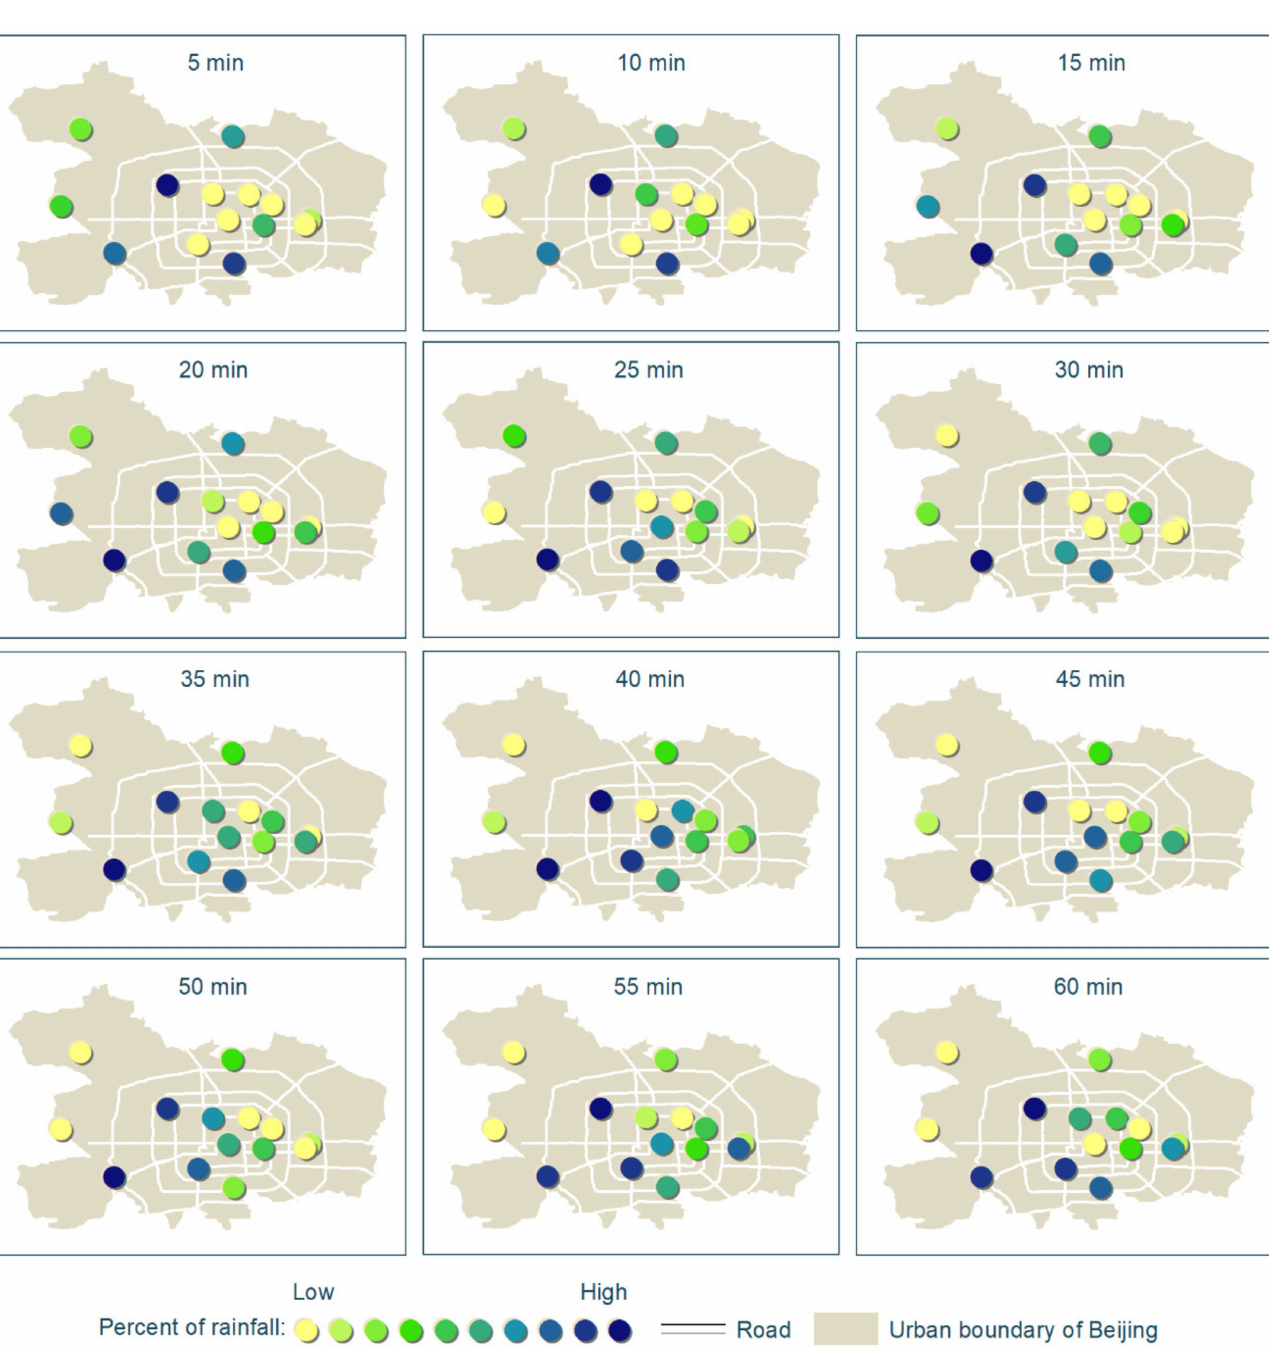
Figure 8. Spatiotemporal process of mode